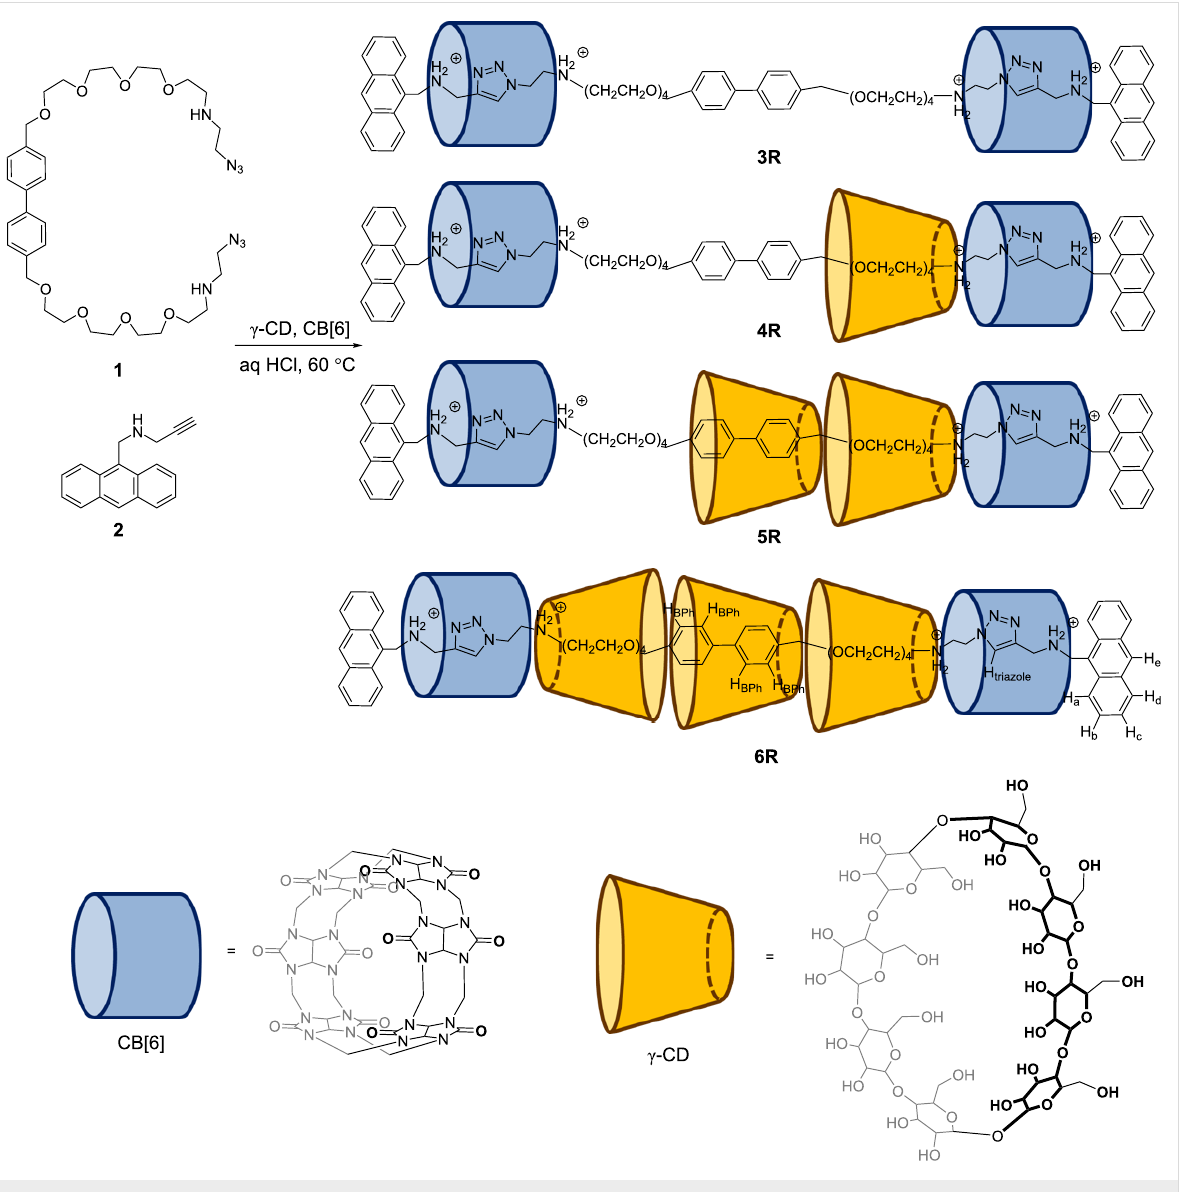
Scheme 2: Synthesis of [ n ]rotaxanes 3R to 6R . Note that the position and orientation of the γ -CD are arbitrary.